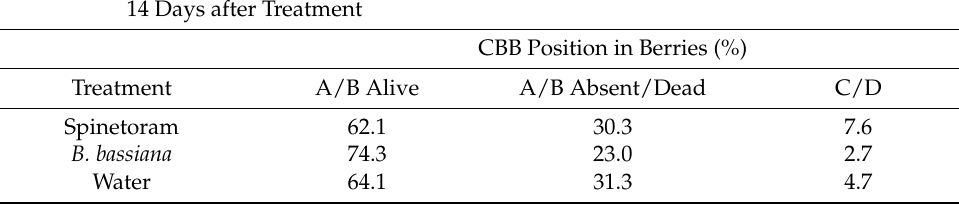
CBB Position in Berries (%)